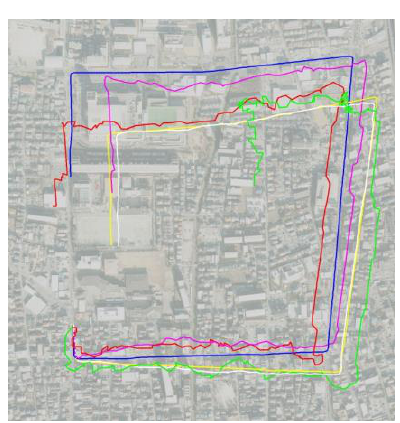
Figure 6. results of EKF